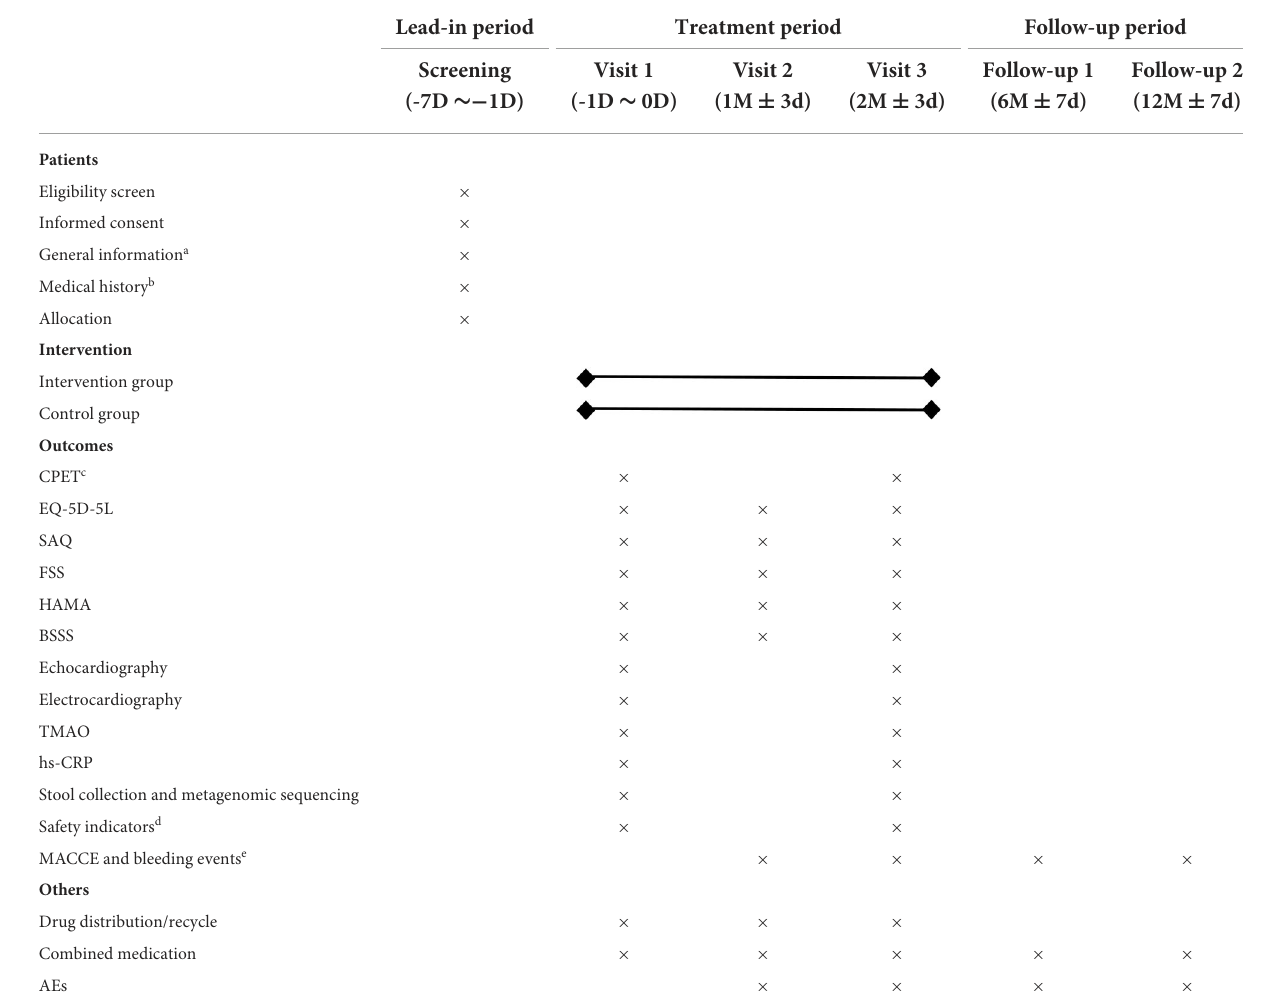
TABLE 2 Measurement items and points of data capture.